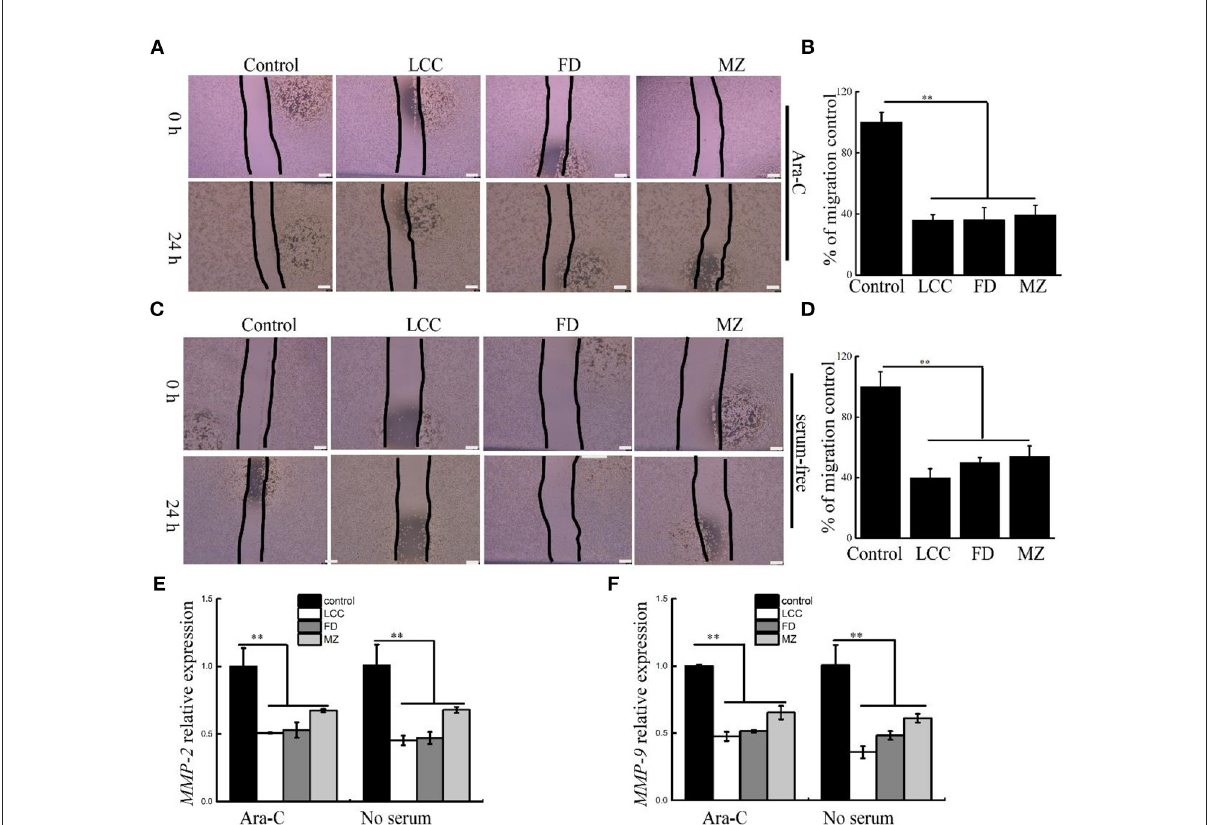
FIGURE4 The effects of TEVs on the migration of LX-2 cells. (A) Representative images were shown and the edges of the wounds are marked by black lines after treatment with Ara-C and TEVs in a scratch wound assay. Scale bar = 100 µ m. (B) The area of each wound were quantified in (A) . (C) Representative images were shown and the edges of the wounds are marked by black lines after treatment with serum-free and TEVs in a scratch wound assay. Scale bar = 100 µ m. (D) The area of each wound were quantified in (C) . (E) mRNA expression of MMP-2 was analyzed by Real-time PCR. (F) mRNA expression of MMP-9 was analyzed by Real-time PCR. Error bar represents SD ( n = 3; * P < 0.05, ** P < 0.01, indicating significantly different from control